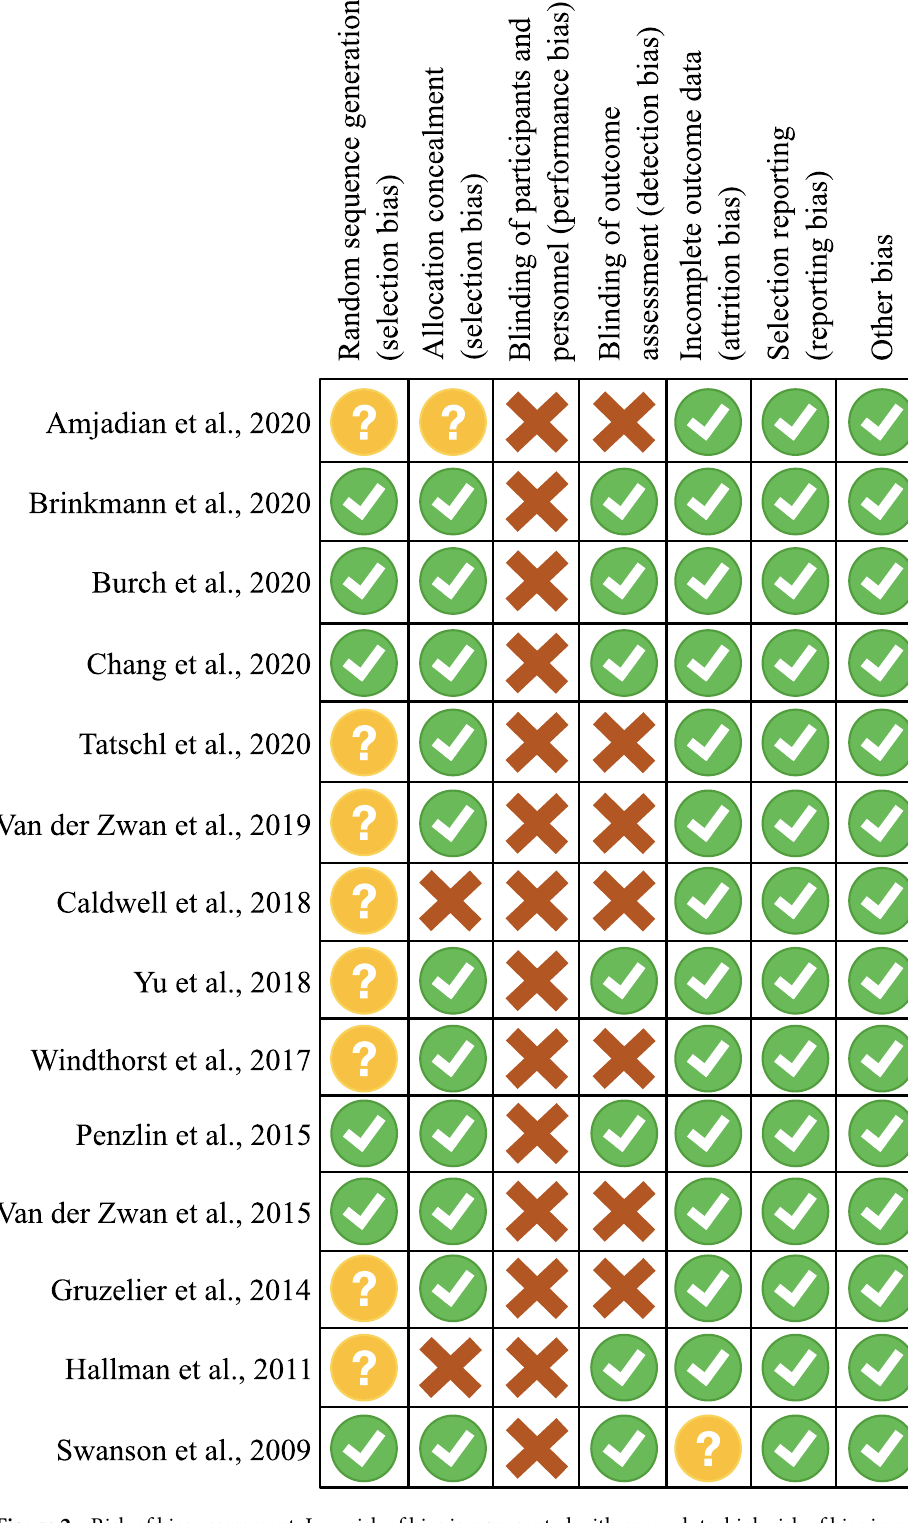
Figure 2. Risk of bias assessment. Low risk of bias is represented with green dots, high risk of bias in red, unclear risk of bias in